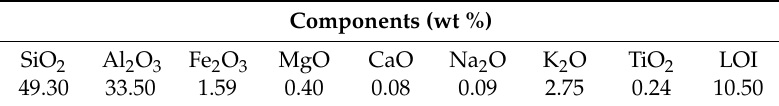
Table 1. Chemical composition of KT2 kaolin